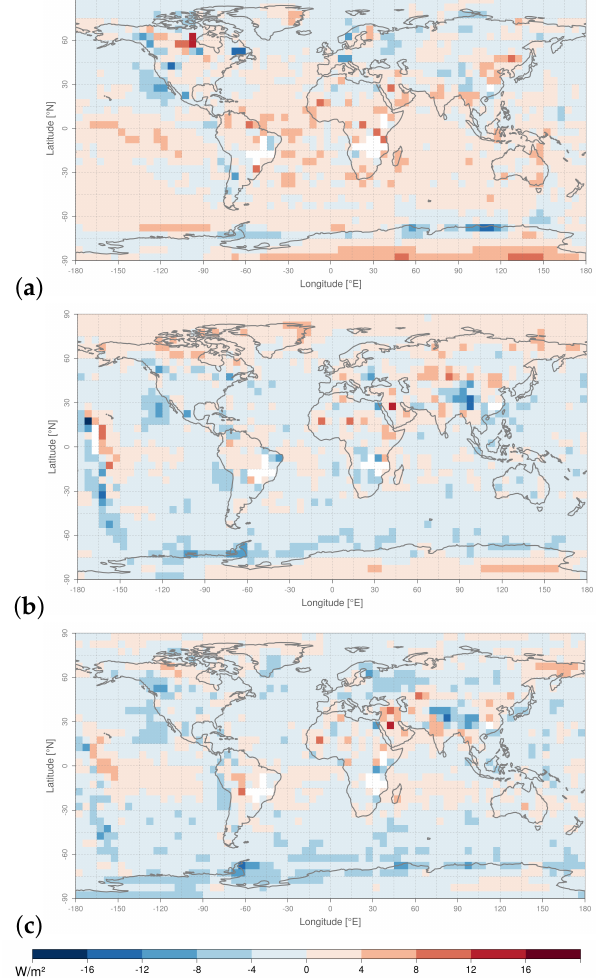
Figure 6. Satellite-specific flux-equivalent Mean Bias ( MB flux , sat ) between observed and estimated broadband reflectance, for all-sky conditions; estimated values are calculated by applying surface-type-dependent regressions on the narrowband observations. Biases are calculated on expanded validation database (with relaxed matching criteria), narrowed down to each of the satellite combinations ( a ) NOAA17/Terra, ( b ) NOAA19/Aqua, ( c ) NOAA18/Aqua; grid boxes with less than 32 observations are excluded and appear white in the